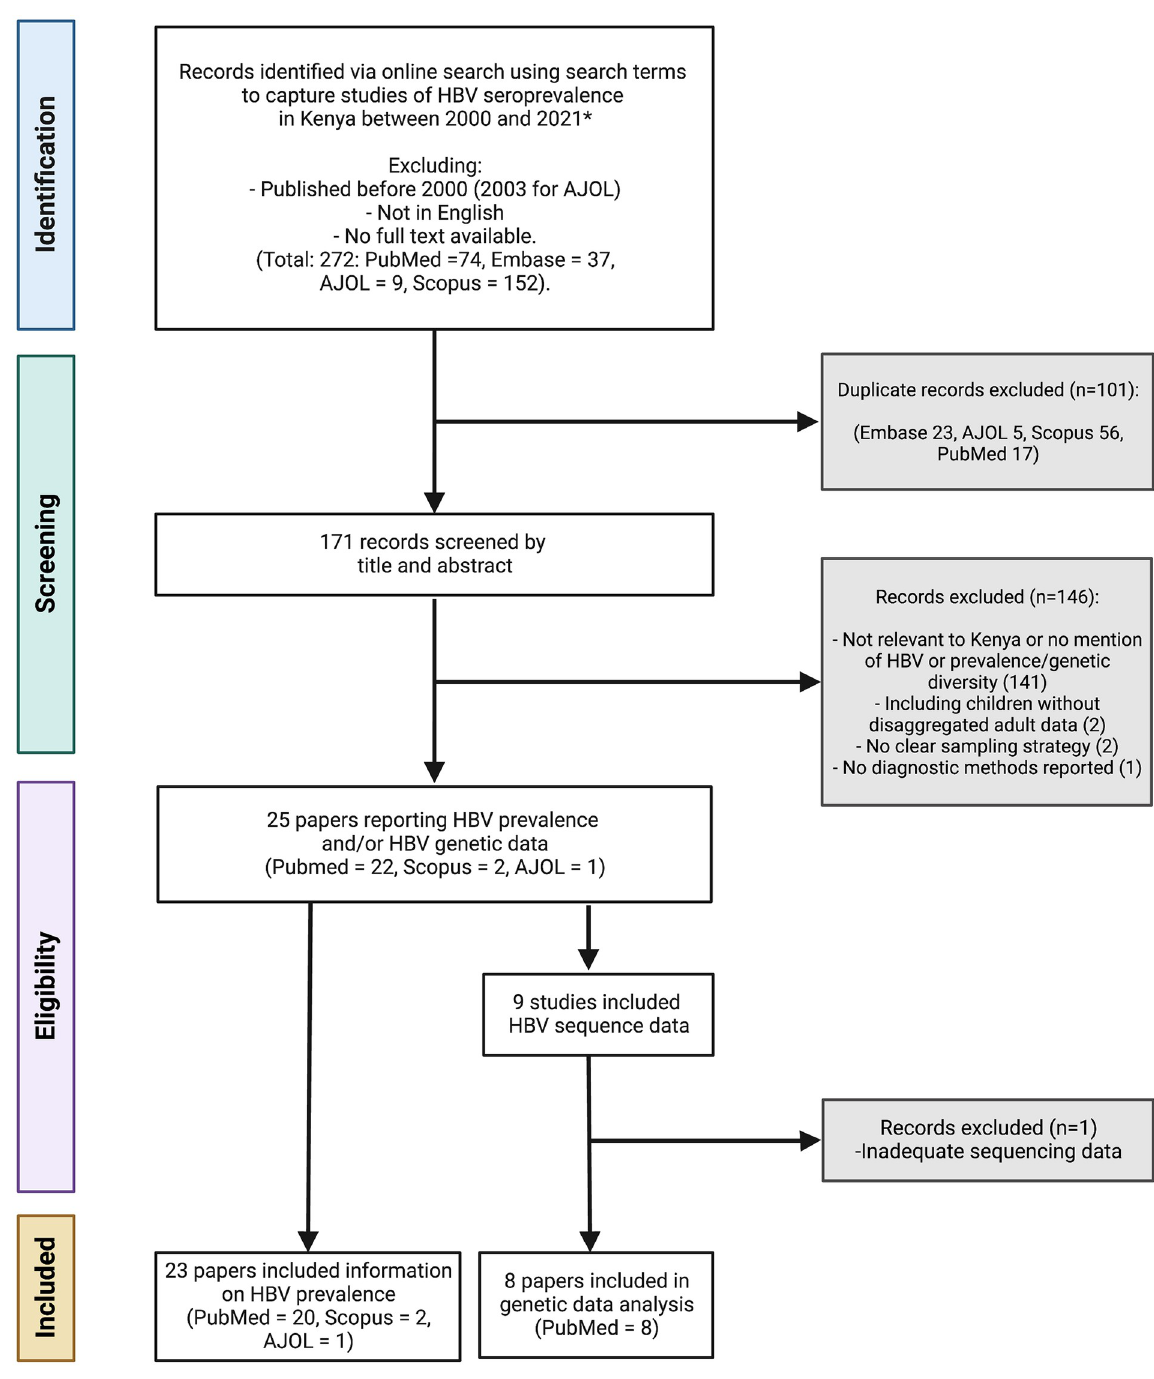
Fig 1. Flow chart for eligibility of studies included in a systematic review reporting prevalence and genetic data for HBV in Kenya between 2000–2021. (AJOL: African Journal Online). All eight studies included for genetic analysis contain information on HBV genotype. Figure created in Biorender.com with licence to